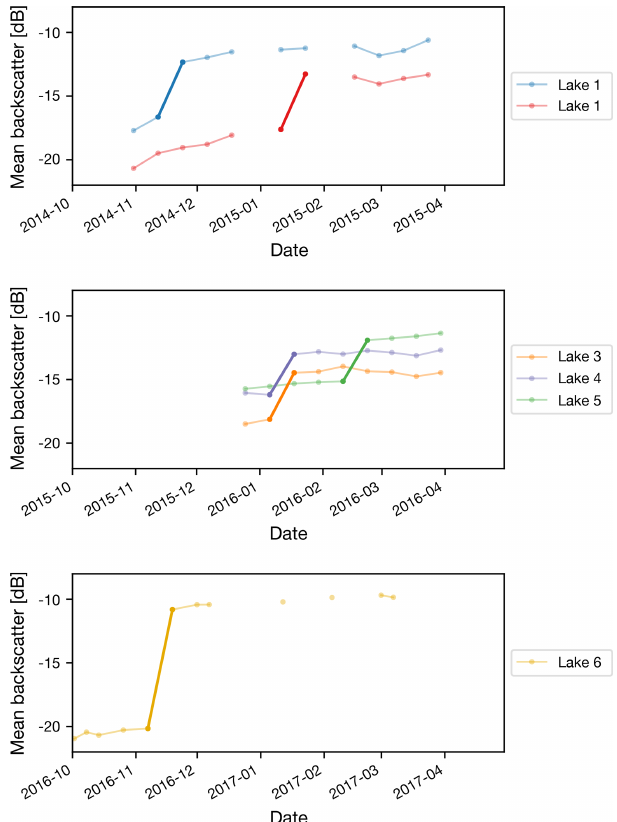
Figure 4. Backscatter time series for the lakes with identified drainage events. Connecting lines are only included when the time between images is 12d or less. Each series represents one lake, and each point represents the mean backscatter of all of the lake’s pixels in a particular Sentinel-1 image. Bold lines indicate the transition determined to be the drainage